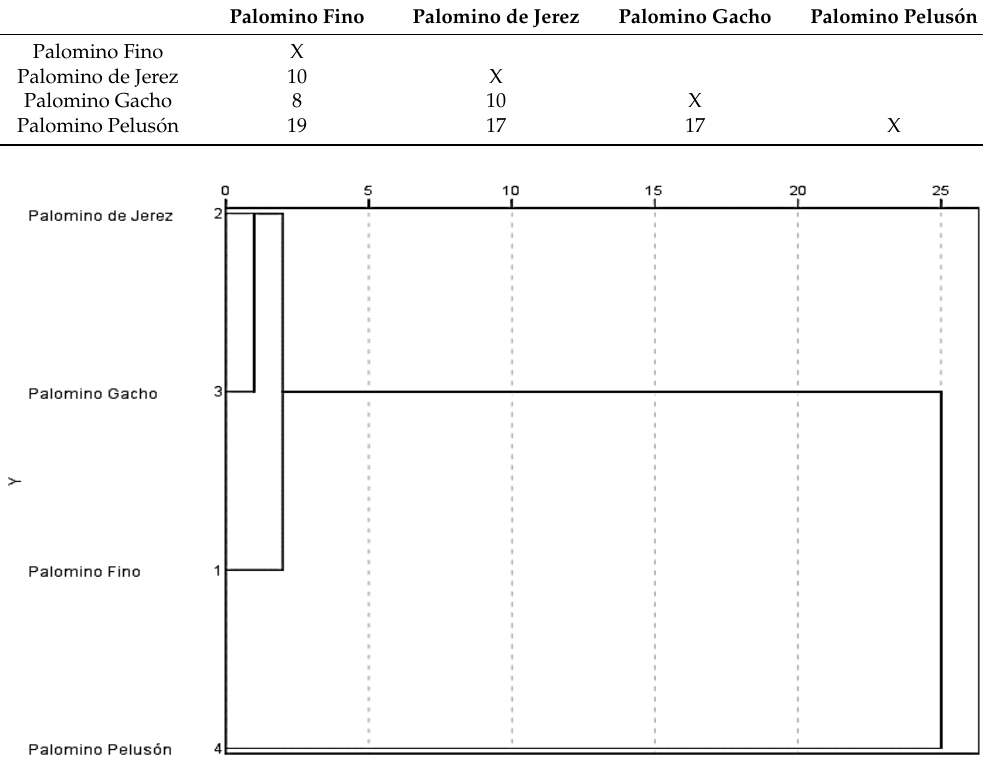
Table 2. Number of different descriptors between the different somatic variants (Palomino de Jerez, Palomino Gacho and Palomino Pelusón) and the control Palomino Fino.